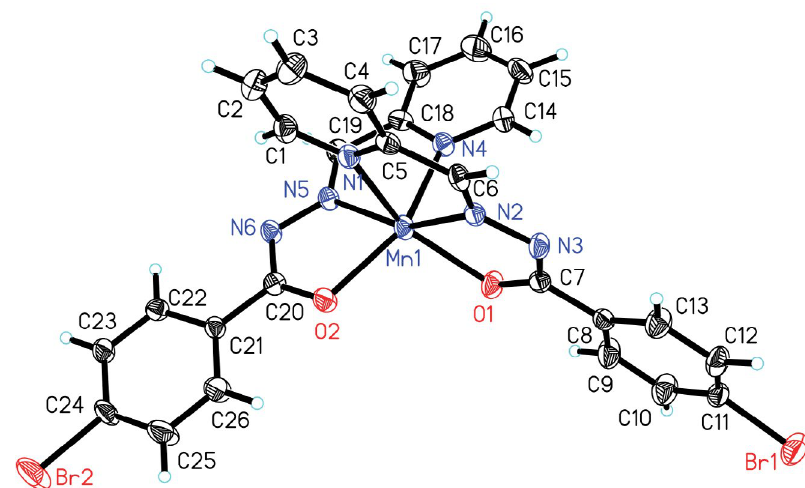
Figure 5. Molecular structure of 2 , showing the atom-numbering scheme. Displacement ellipsoids for non-hydrogen atoms are drawn at 30% prob- ability